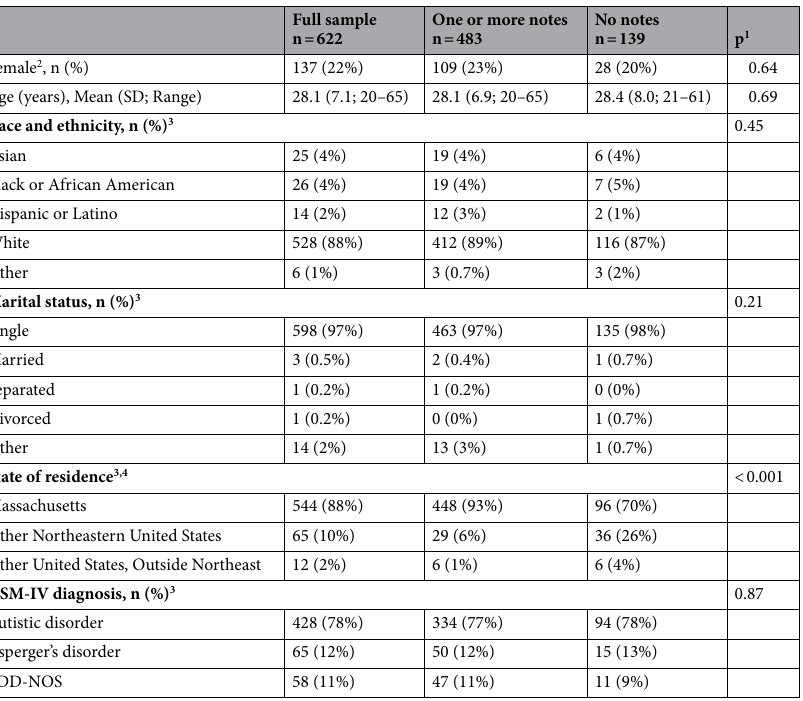
Table 1. Characteristics of ASD patients with and without one or more notes from the past 5 years in their electronic health record. DSM-IV Diagnostic and Statistical Manual of Mental Disorders, Fourth Edition, PDD-NOS pervasive developmental disorder-not otherwise specified. 1 Fisher’s exact test and Welsh’s t test compared characteristics of patients with and without notes from the past 5 years in their electronic health record. 2 All patients were identified as either male or female in the patient data registry. 3 Race and ethnicity categories were taken from the patient data registry. Race was not reliably identified for Hispanic or Latino adults. Race was missing for 18 adults (4%) with one or more notes from the past 5 years and 5 adults (4%) without notes from the past 5 years. Marital status was missing for 4 adults (0.8%) with one or more notes and 1 adult (0.7%) without notes. State of residence was missing for 1 adult (0.7%) without notes. DSM-IV diagnosis was missing for 52 adults (11%) with one or more notes and 19 adults (14%) without notes. 4 Other Northeastern states represented were New Hampshire (n = 31), Connecticut (n = 9), New York (n = 6), Vermont (n = 6), New Jersey (n = 4), Rhode Island (n = 4), Maine (n = 2), Pennsylvania (n = 2), and Maryland (n = 1). States outside the Northeastern United States represented were Florida (n = 6), Alabama (n = 1), Arizona (n = 1), California (n = 1), Michigan (n = 1), North Carolina (n = 1), and Wisconsin (n =